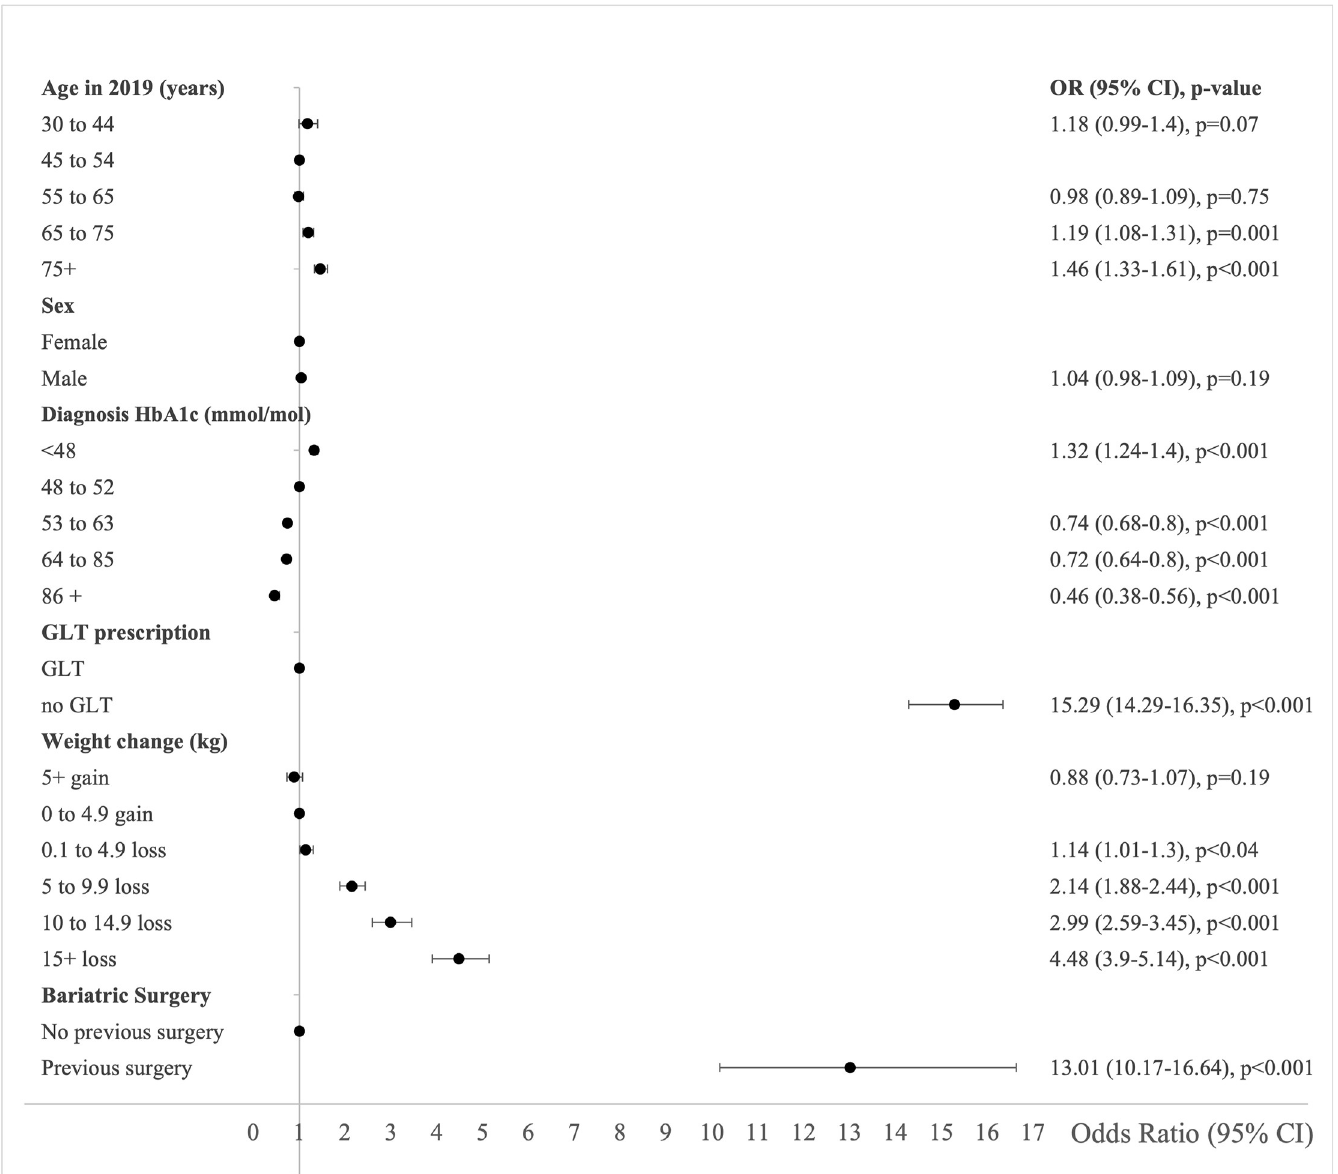
Fig 4. ORs for remission of type 2 diabetes (95% CI) in Scotland 2019 derived from multivariable logistic regression model adjusted for all covariables listed on the plot with multiple imputation for missing data. People with previous history of dementia, end-stage renal disease, liver cirrhosis, cancer, or metastases in the last 5 years removed. N = 152,934. CI, confidence interval; GLT, glucose-lowering therapy; OR, odds